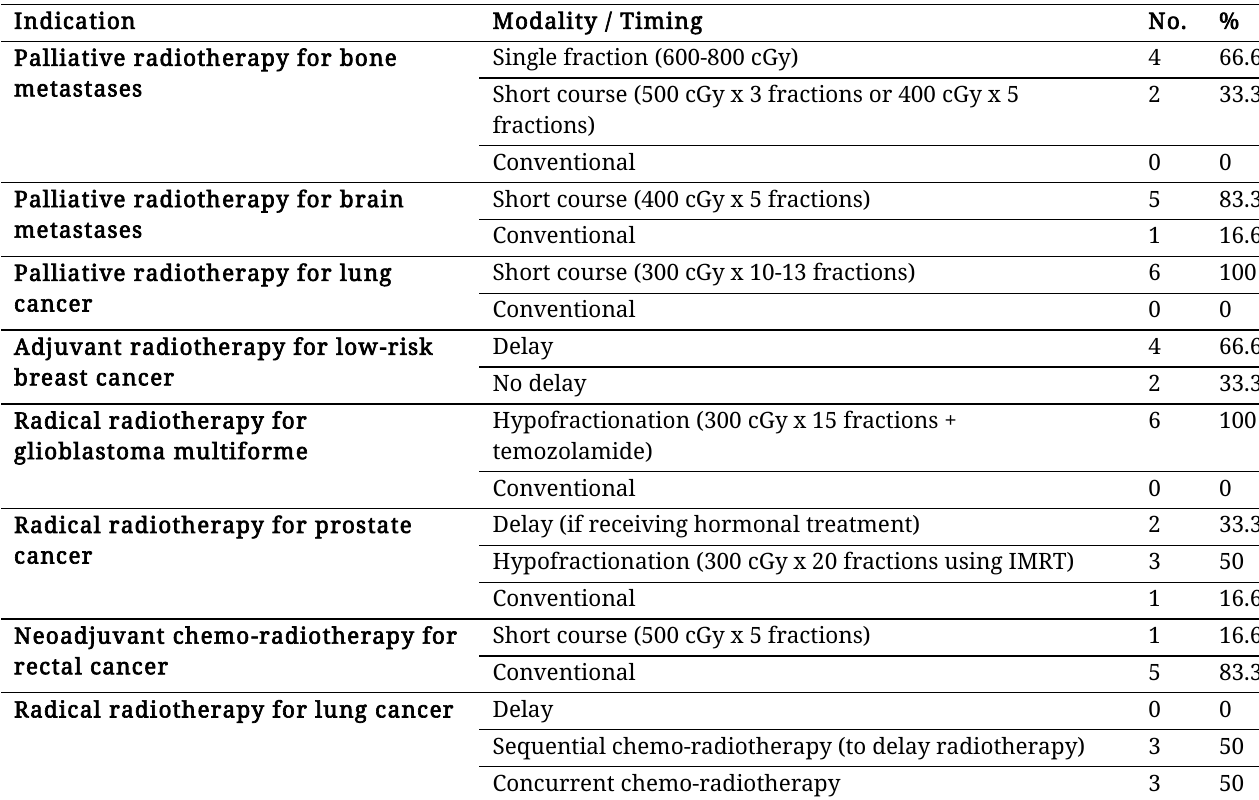
Table 2: The choice / timing of treatment modality involving radiotherapy in selected indications